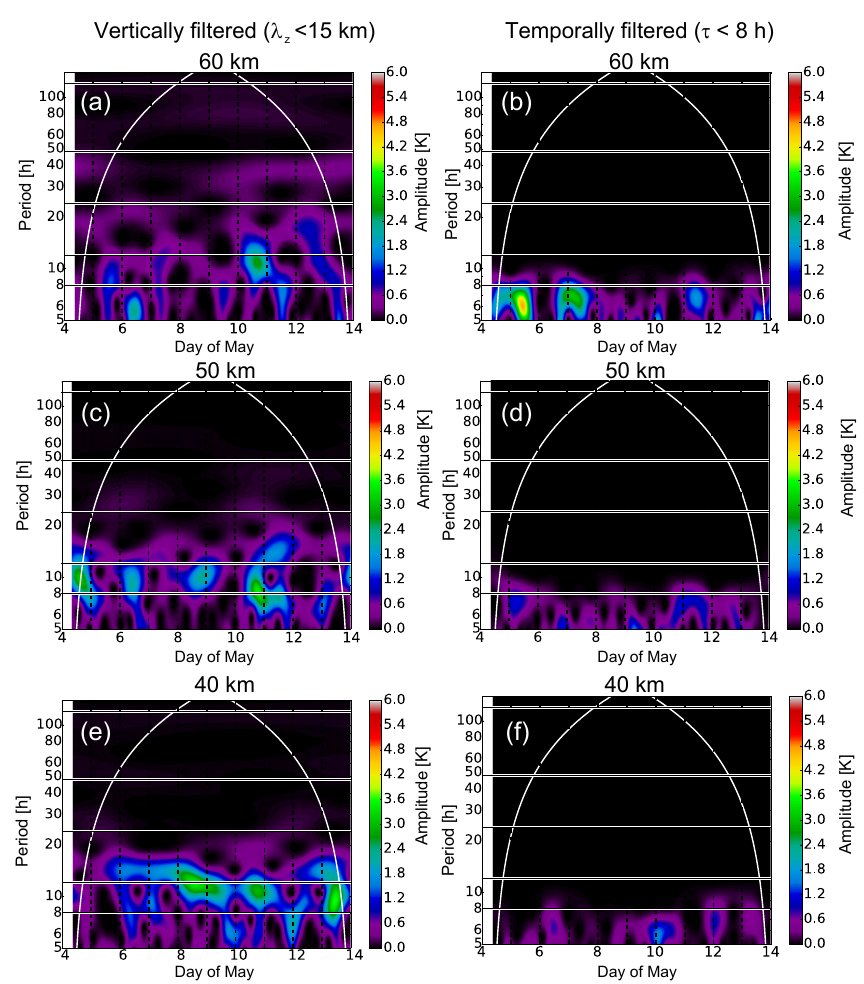
Figure 6. Wavelet spectra for periods of gravity waves calculated from vertically (a, c, e) and temporally filtered data (b, d, f) on 4– 13 May 2016 at an altitude of 40 (e, f) , 50 (c, d) , and 60km (a, b) . The horizontal lines indicate periods with 8, 12, 24, 48, and 120h. The curved white line shows the edge of the cone of